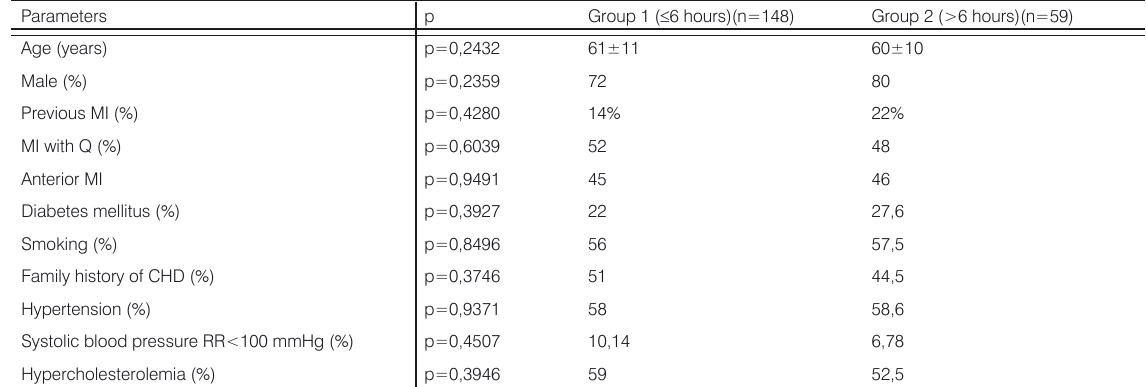
Table 1. Baseline characteristics of